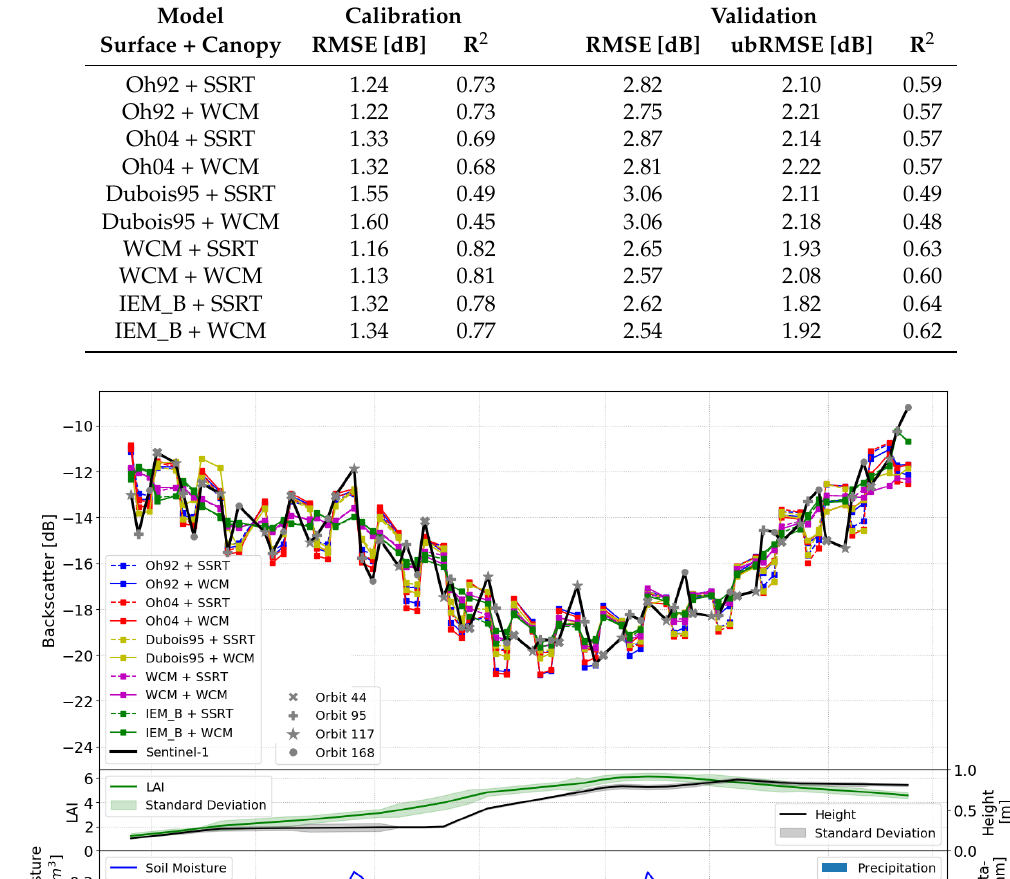
Table 7. Calibration and validation results of different model combinations with non-static empirical parameters. Mean RMSE, ubRMSE, and R 2 of all analyzed field measurement points.